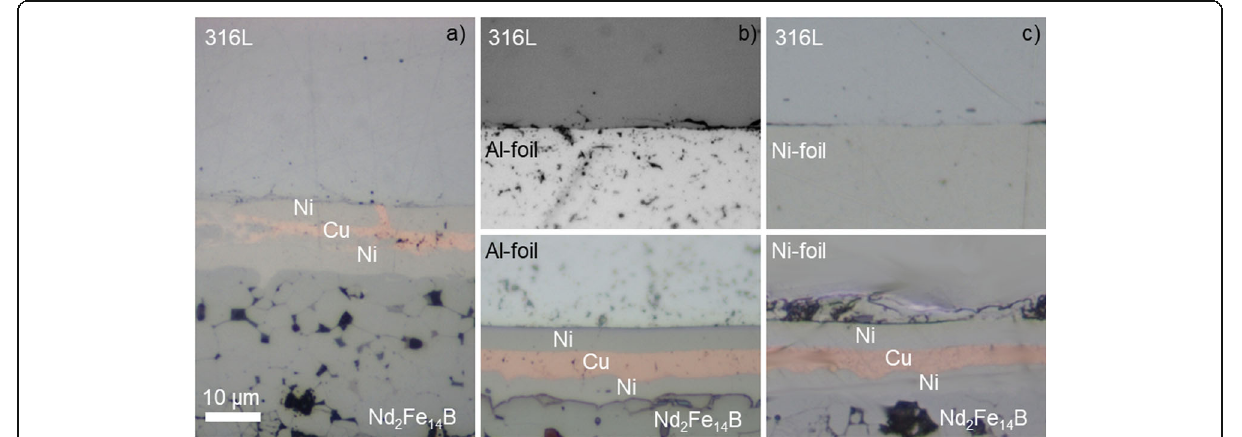
Fig. 9 Microstructure of ultrasonically welded joints: a 316L/Nd 2 Fe 14 B b 316L/Al/Nd 2 Fe 14 B and c 316L/Ni/Nd 2 Fe 14